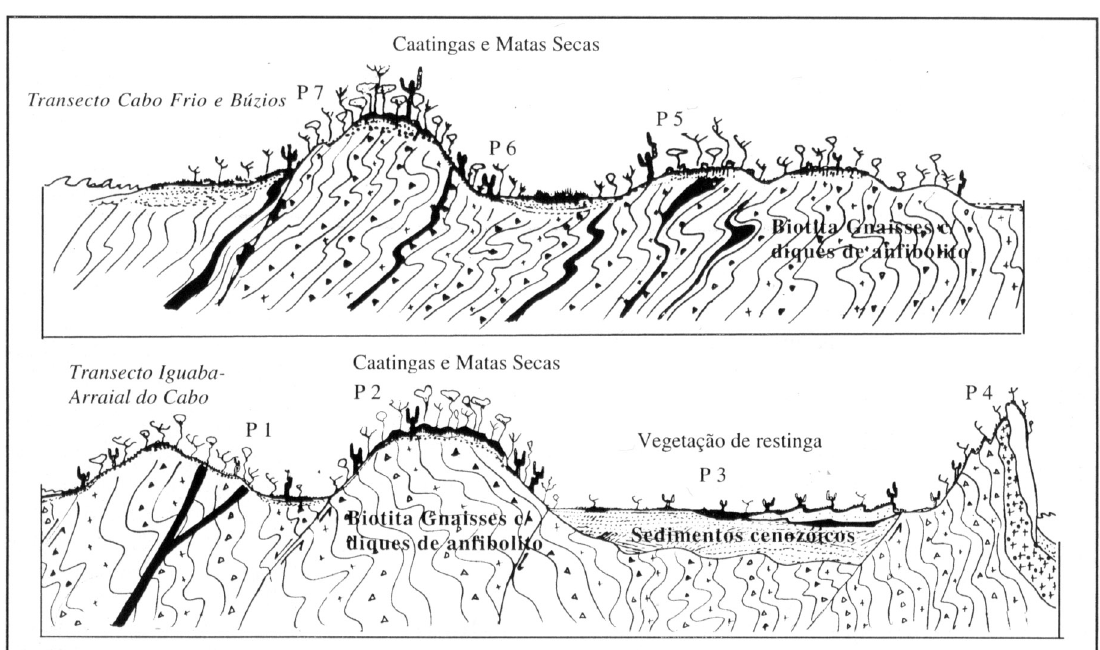
Figura 2. Corte esquemático e localização dos perfis nos dois transectos estudados na região dos Lagos (RJ).